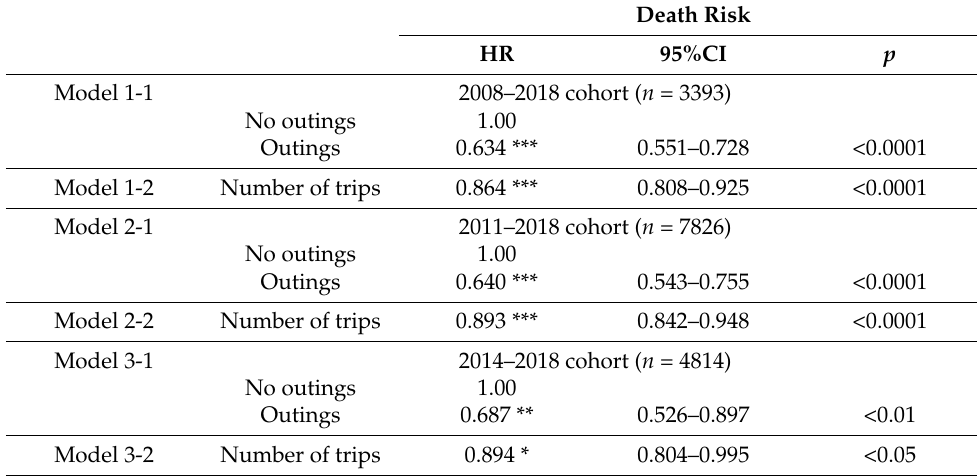
Table 2. Effect of travel on mortality risk in elders.